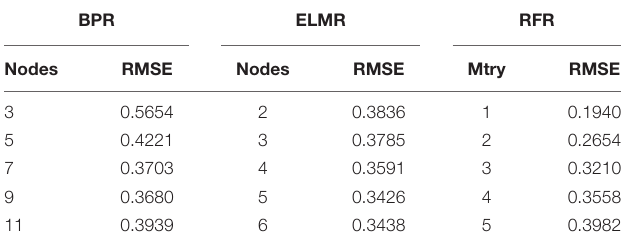
TABLE 2 | RMSE of models with different Nodes or Mtry .